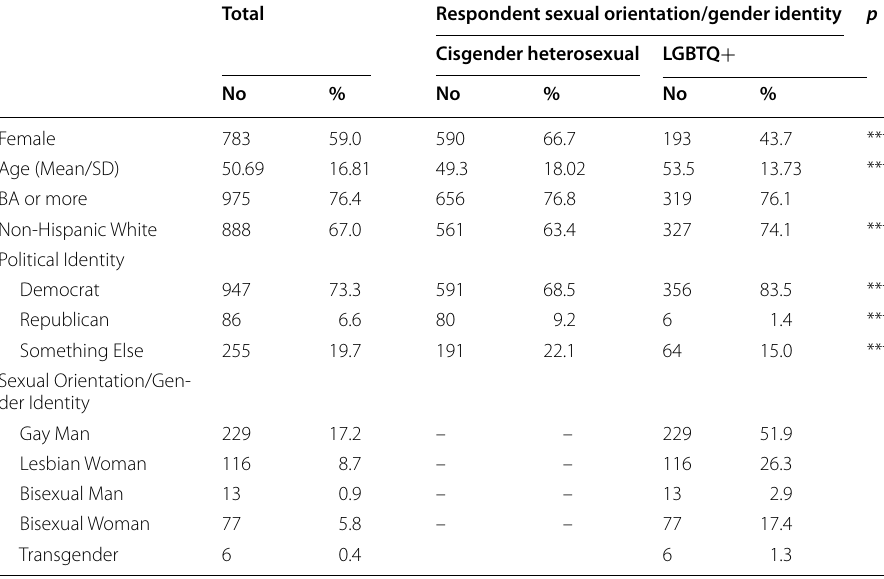
Excludes respondents who were lost to follow up at Wave 2. * p < .05, ** p < .01, *** p < .001